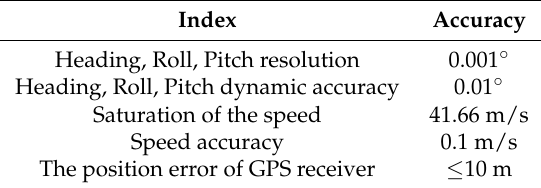
Table 3. Specifications of the GPS/PHINS integrated navigation system.